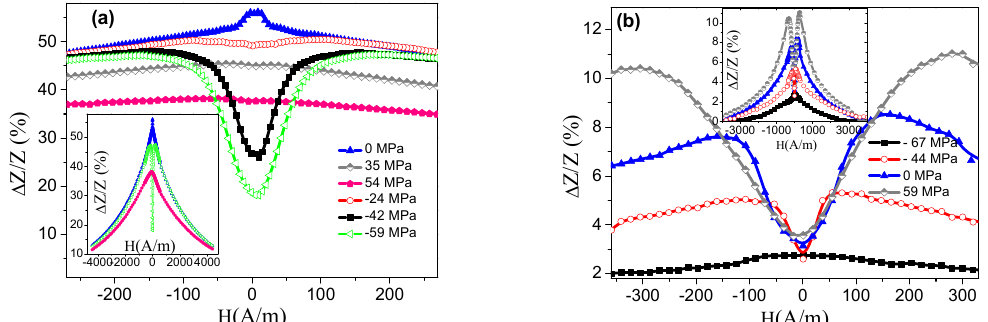
∆(cid:3027) (%) , with H for samples ( a ) P 1 (cid:3027)